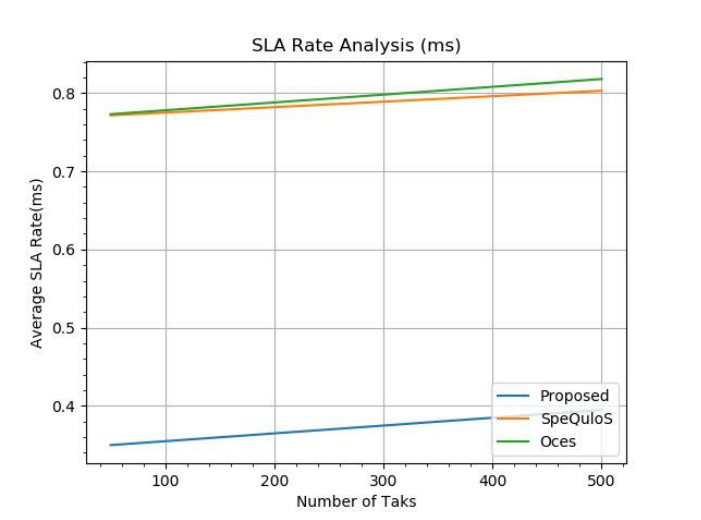
Figure 4. SLA Violation rate Analysis of proposed work